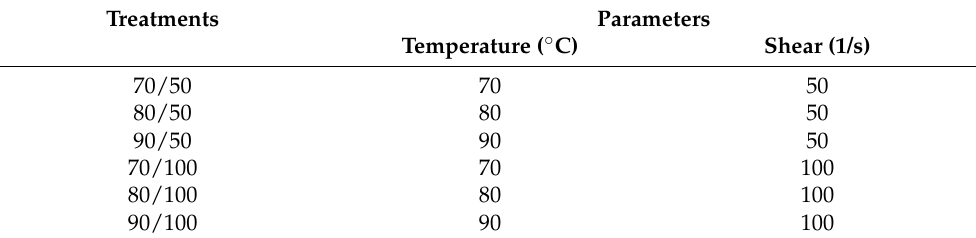
Table 1. Conditions used for the preparation of oatmeal pastes in DHR-3. Treatments Parameters Temperature ( ◦ C) Shear (1/s) 70/50 70